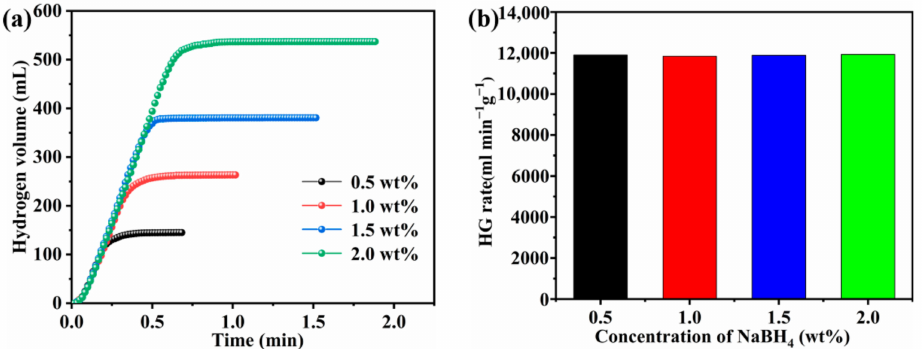
Figure 10. ( a ) Effect of NaBH 4 concentrations on the HG rate (batch system, 25 ◦ C, 5 wt% NaOH, 0.1 g of catalyst); ( b ) HG rate versus NaBH 4